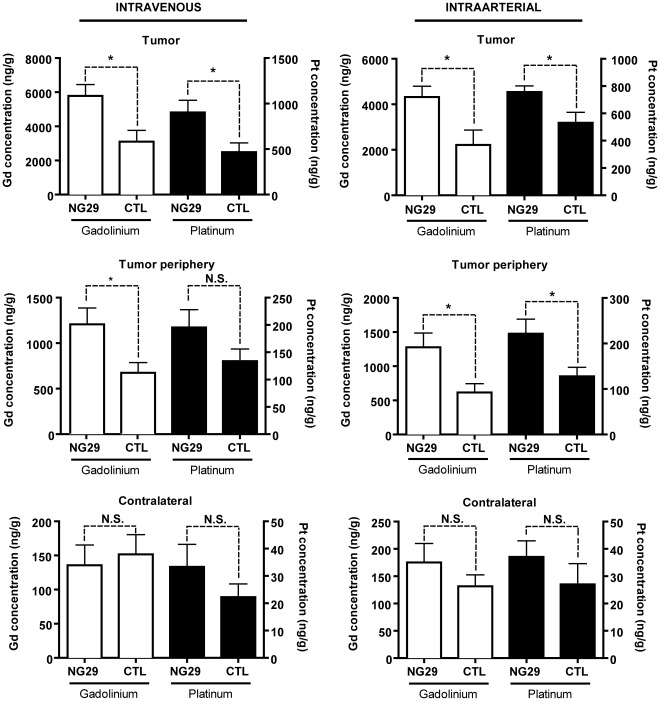
NG29 induces changes in local concentration of gadolinium and platinum in tumoral cerebral tissues.Direct measures of drug concentration (ng/g of tissue) by ICP-MS in three different tissue extracts (tumor, tumor periphery and contralateral) from the brain of F98 glioma-bearing Fischer rats were made following intraarterial (carotid artery) or intravenous (femoral vein) injections of Gd-DTPA (Gd) (143 mM i.v.) and carboplatin (Pt) (20 mg/kg i.a. or i.v.) with the B1R agonist NG29 (250 nmol/kg i.a.; 5 µmol/kg i.v.) or saline (CTL). Note the difference in ordinate scaling between drug concentrations in contralateral and tumoral tissues. Data are mean ± S.E.M. of 7–10 rats in each group. *p<0.05 versus respective control; N.S.: non significant.